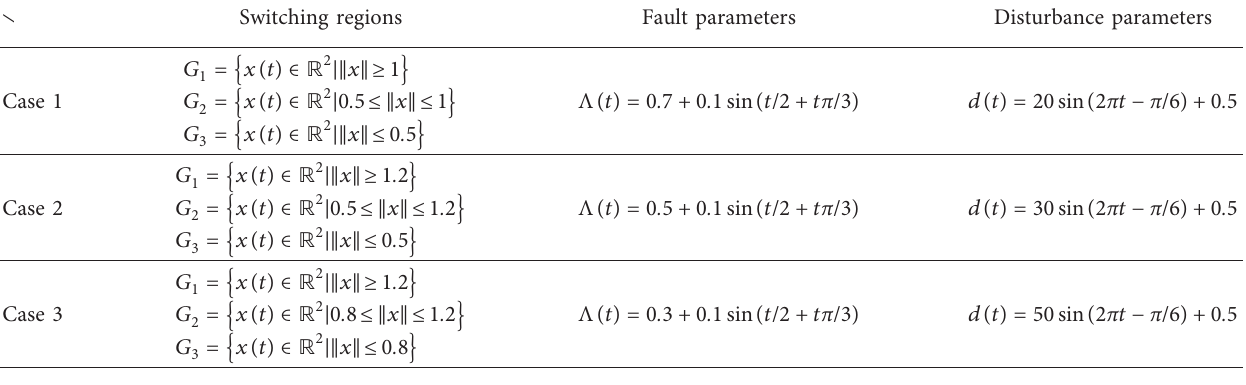
Table 2: The parameters of the three simulation cases.